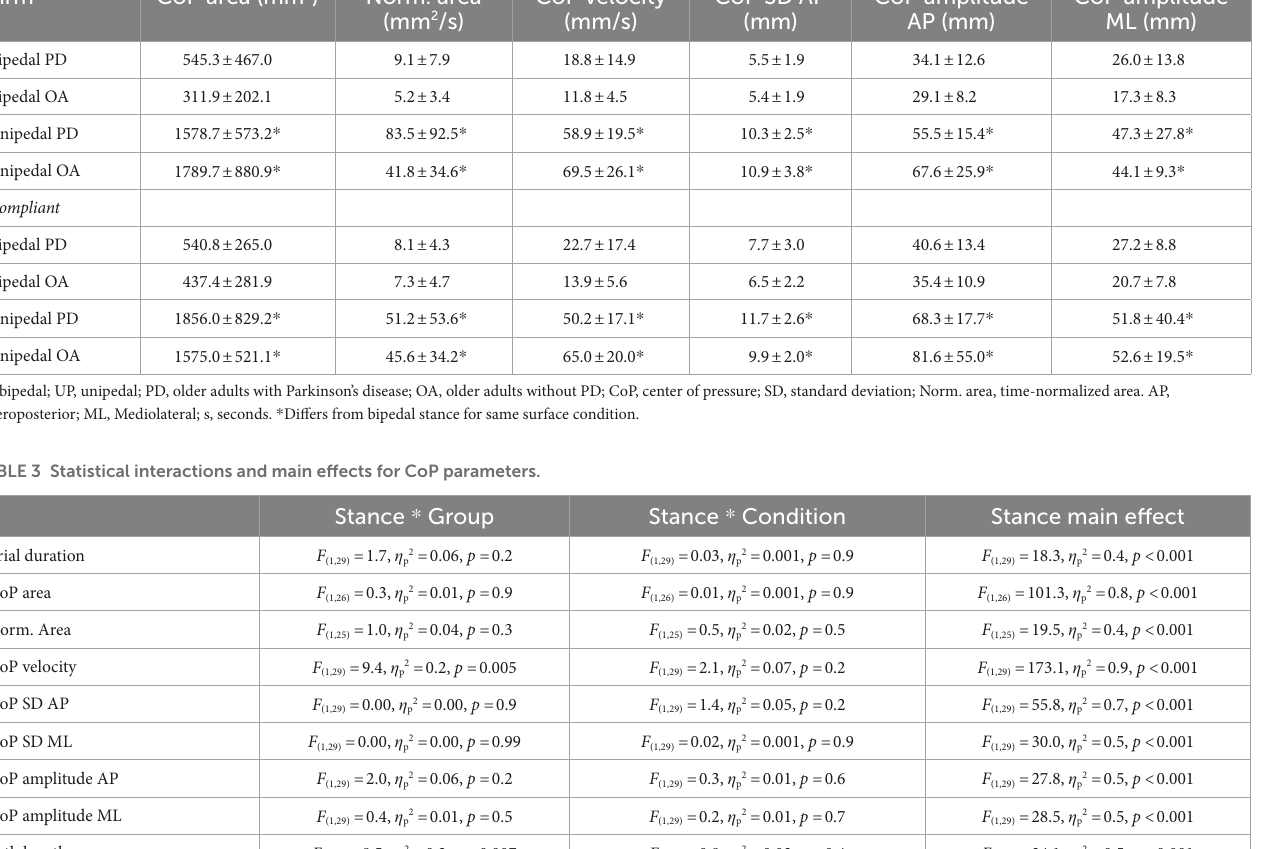
TABLE 2 Center of pressure (CoP) parameters for older adults with Parkinson’s disease and older adults without PD in bipedal and unipedal stances during firm and compliant surface conditions. Firm